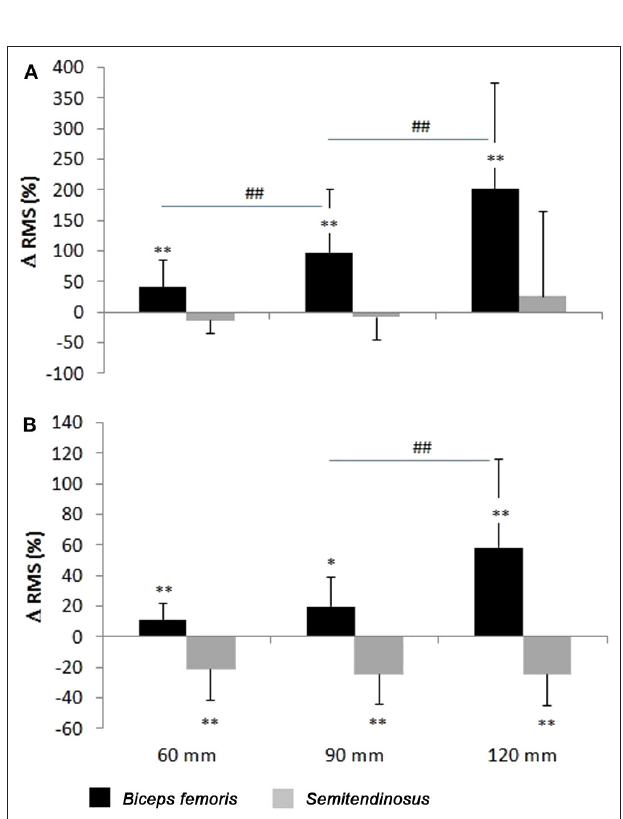
FIGURE 8 | The activation of biceps femoris (BF) and semitendinosus (ST) (mean ± SD) with 40 ◦ (A) and 60 ◦ (B) knee flexion. *Depicts statistical significant difference against W(0), and # depicts statistical significant difference with the previous (narrower) waist width.